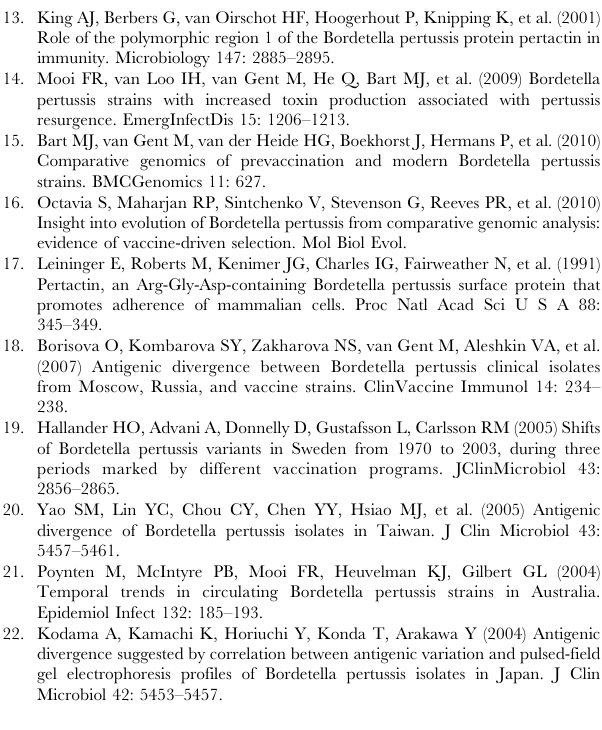
Table S1 Characteristics of the strains used in this study. Table S2 Analyses of variance of the effect of B. pertussis polymorphisms on colonization of the mouse